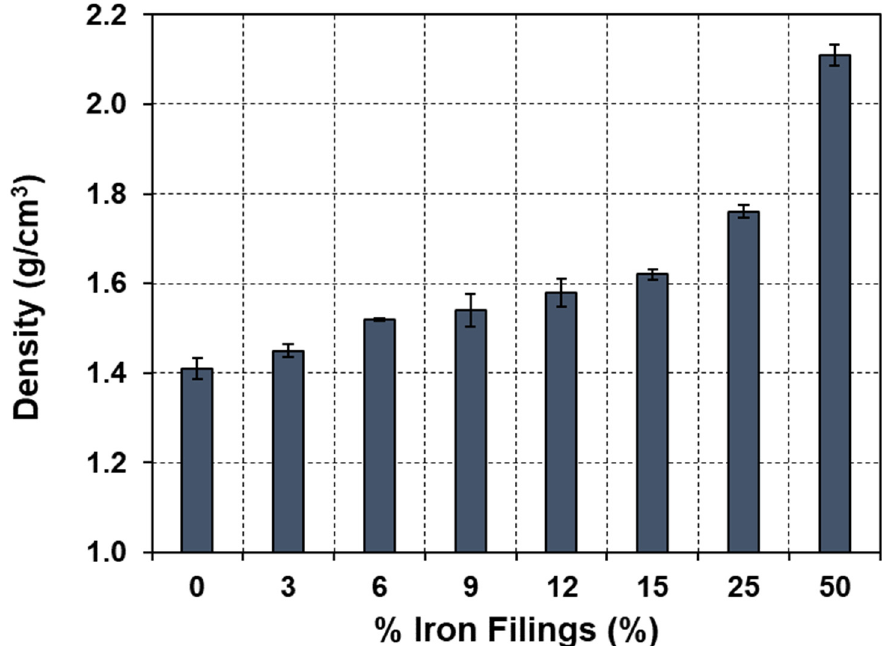
Figure 2. The density of the GFRE composites upon the addition of different WIF amounts.